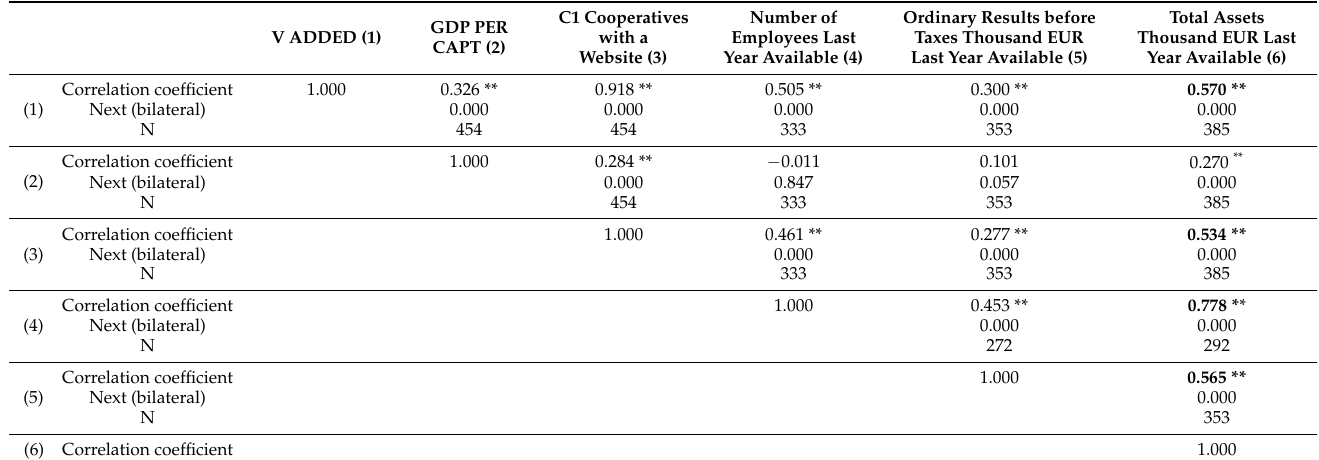
Table 7. Correlations of Spearman Agri-food Coop EU (28). Source: own development. V ADDED